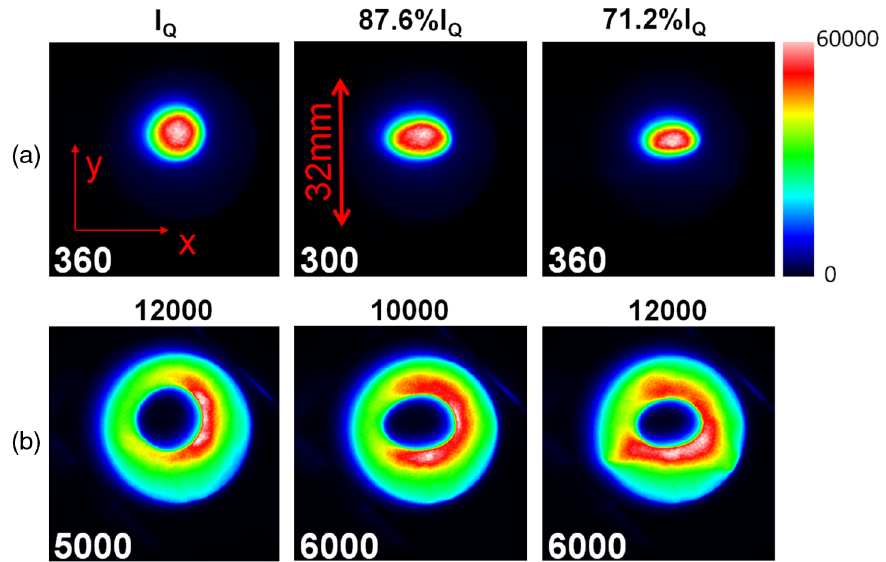
FIG. 17. Comparison of core and halo with changing quadrupole strength. (a) Unmasked beam picture; (b) masked beam picture.